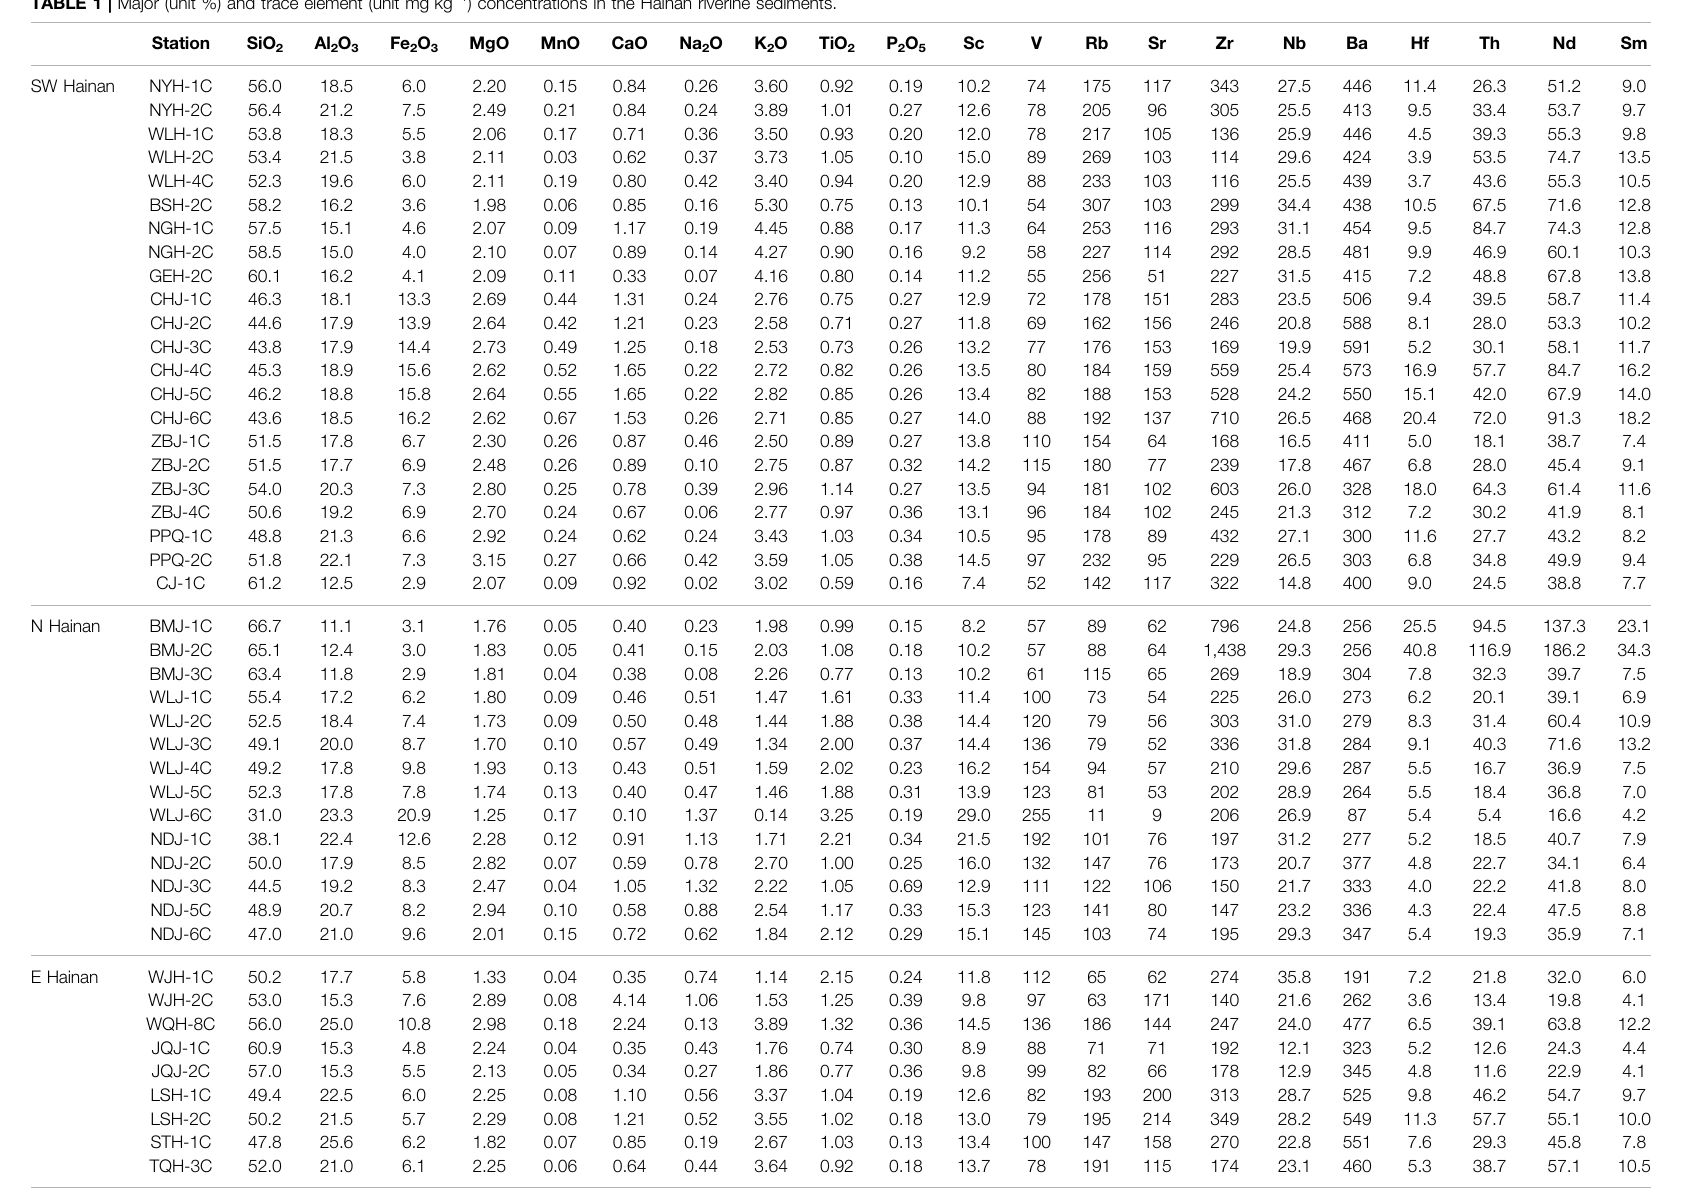
TABLE 1 | Major (unit %) and trace element (unit mg kg − 1 ) concentrations in the Hainan riverine sediments.